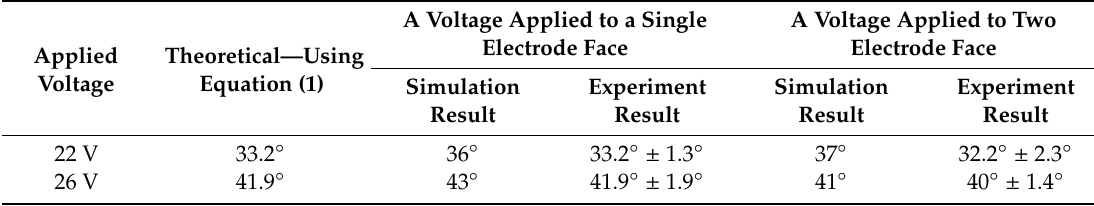
Table 1. Comparison of the change of contact angle ( ∆ θ ).